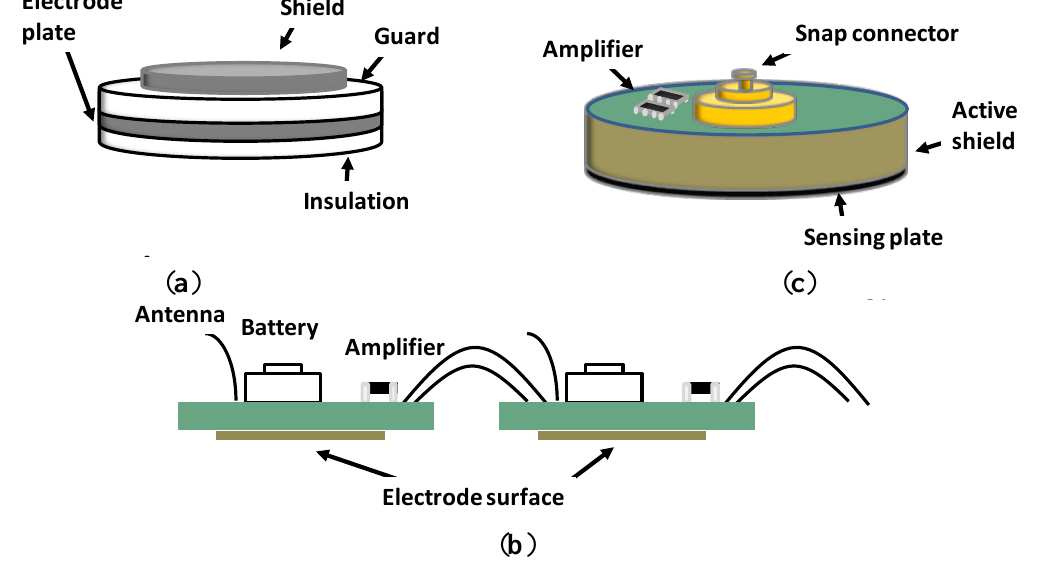
Figure 4. ( a ) Capacitive electrode. Adapted from [22]; ( b ) Non-contact low Power EEE/ECG electrode. Adapted from [23]; ( c ) Dry active electrode made from standard Printed Circuit Board (PCB). Adapted from